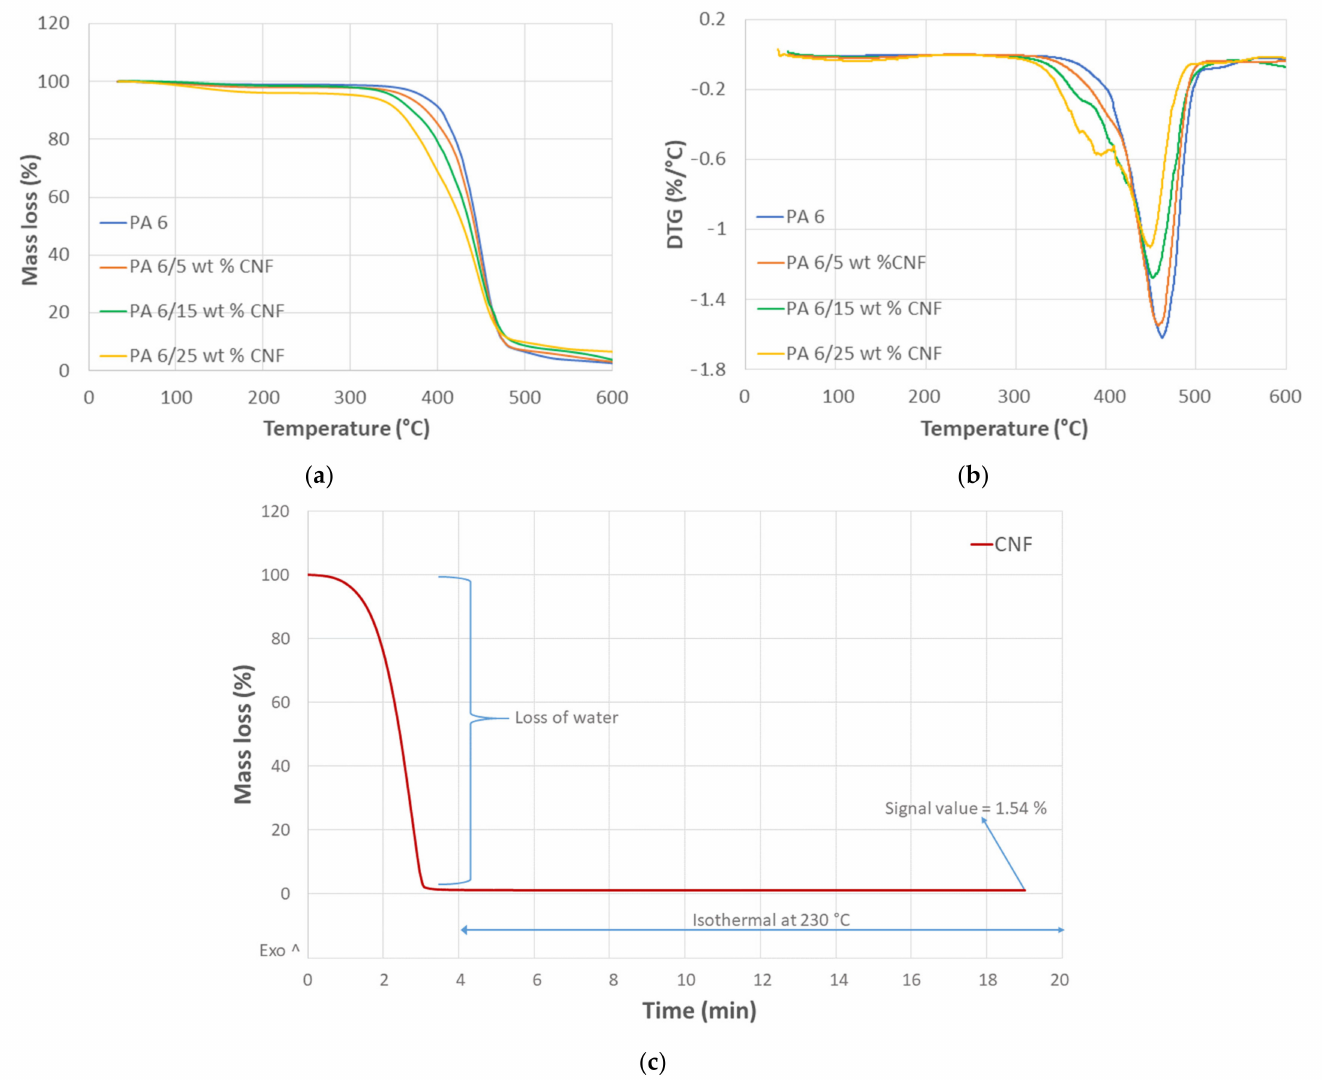
Figure 6. Thermograms, ( a ) TGA, ( b ) DTG for neat PA 6 and PA 6/CNF nanocomposites and ( c ) TGA of CNF gel at isothermal conditions at 230 ◦ C.